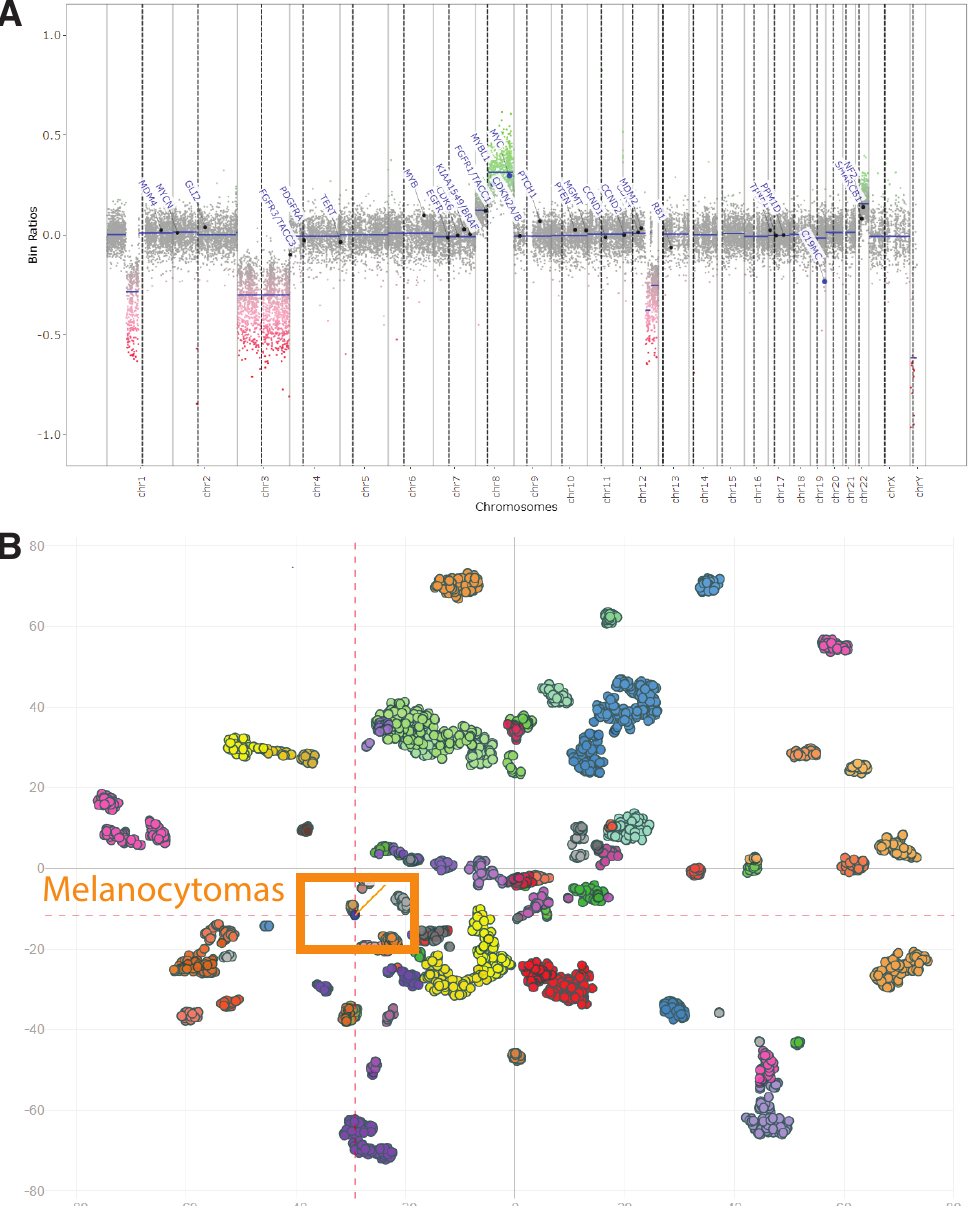
Figure 3. Methylation profiling of the tumor. ( A ). Genome-wide copy number profiles determined from the Illumina Infinium HumanMethylation450 array. The x-axis represents genomic location with each dotted black line marking transition across chromosomes. The y-axis represents signal intensity. Gains represent positive, losses negative deviations from the baseline. Patient tumor demonstrating a relatively stable genome. Please note that there is whole chromosome 3 loss and whole chromosome 8 gain that do not meet the cutoffs for gains (0.5) or losses ( − 0.5) as per validation of the assay. ( B ). t-SNE visualization of methylation classifier groups. Plot of t-SNE dimensions derived from all methylation sites for all samples in the methylation classifier group and individual points represent each sample. Patient tumor (orange line) is displaying similarity with the melanocytomas group (orange